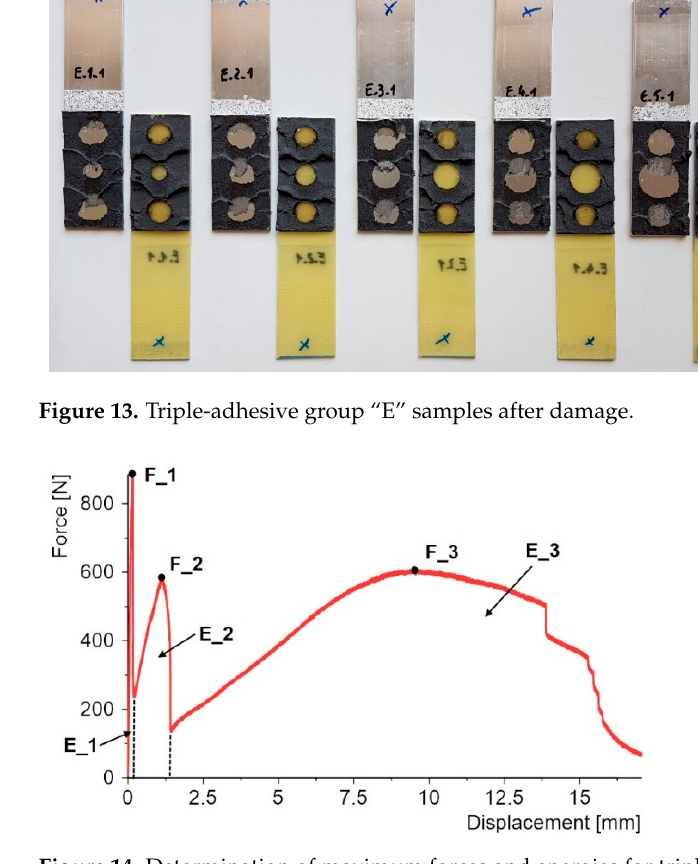
( b ) Figure 15. Summary of maximum forces for samples of group: ( a ) “S” and ( b ) “E”. Analyzing the samples of the “S” group, which had two external rigid bonds, the following cases can occur depending on the diameter of the internal elastic bond, shown in Table 2. Table 2. Relation between forces for “S” group. Case Number